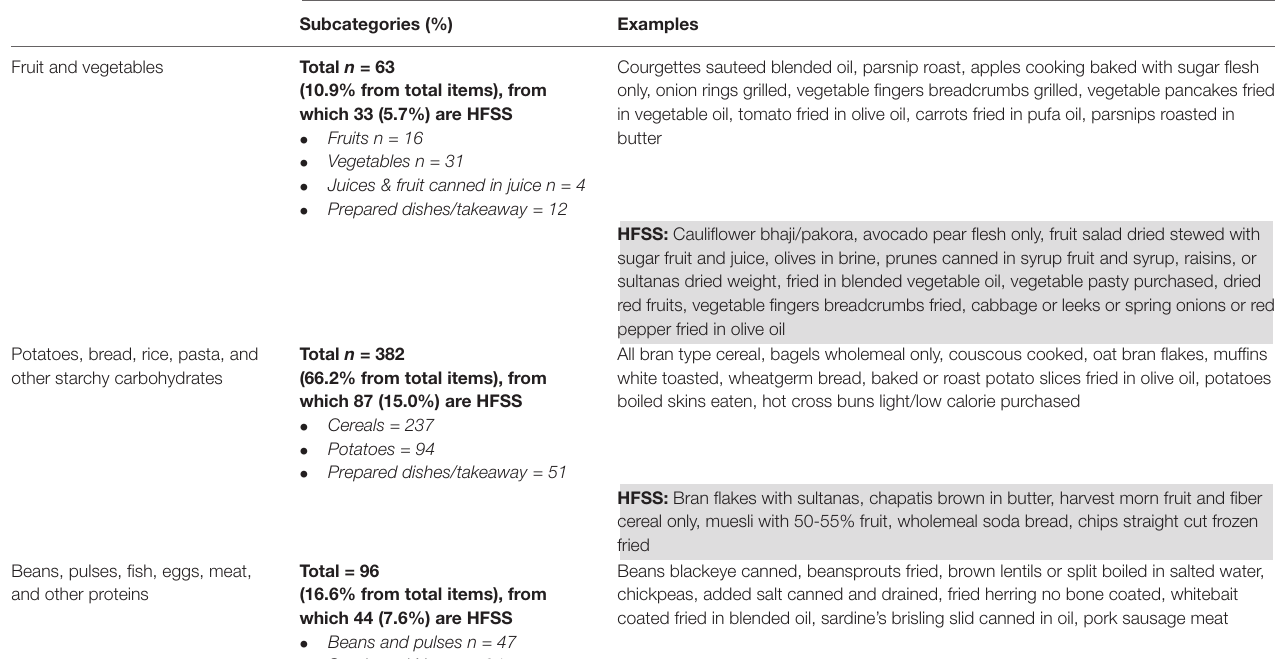
TABLE 4 | Most nutritious, environmentally sustainable, and lower price products.